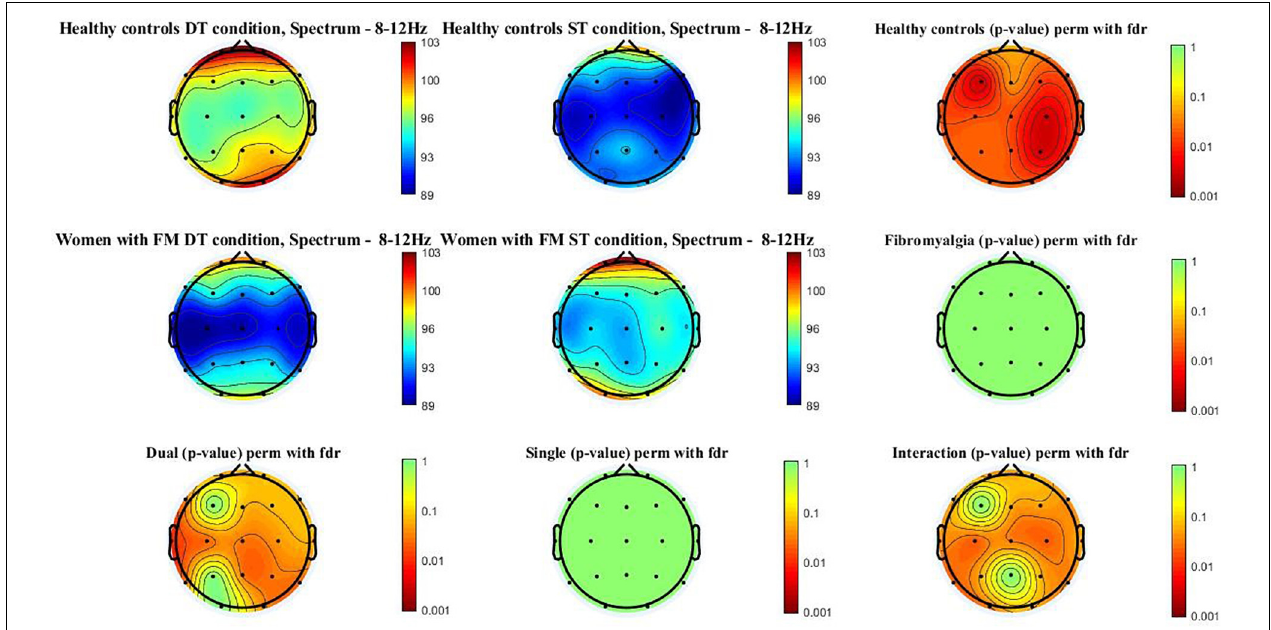
FIGURE 2 | Alpha power spectrum (8–12 Hz) topographic maps in women with FM and healthy controls. Differences were only located ( p < 0.05) between ST and DT conditions in healthy controls and between healthy controls and women with FM in the DT condition. In addition, the interactions group*condition is significant in the following scalp locations: central (Cz, C3, and C4), temporal (T5 and T6), and occipital